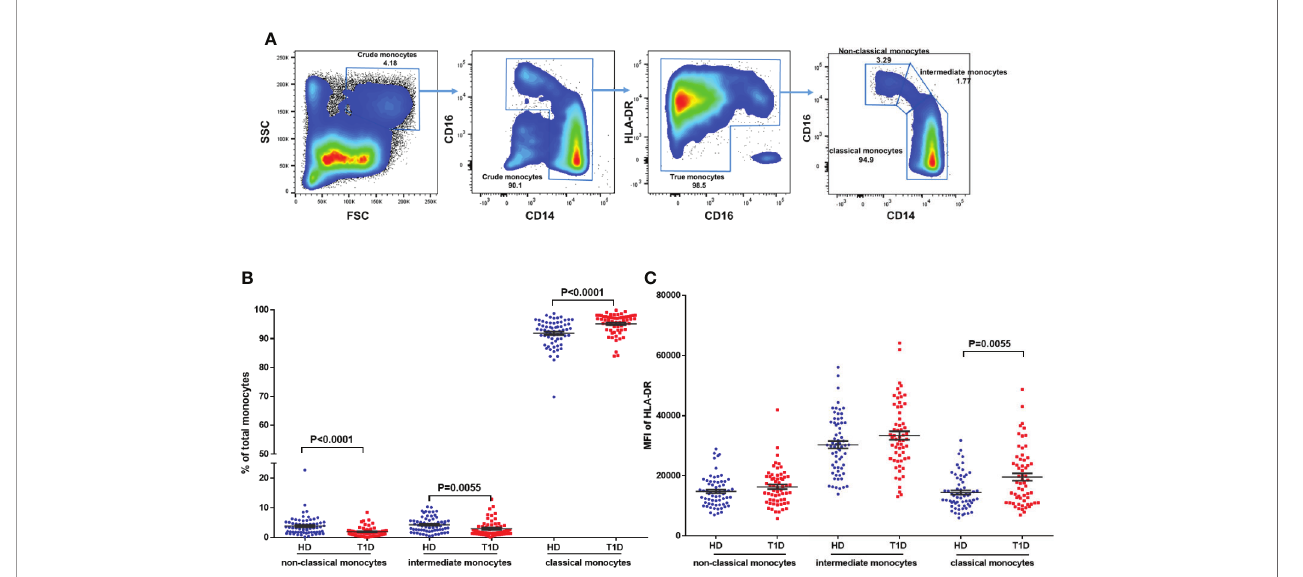
FIGURE 6 | Differences in HLA-DR expression and distribution in circulating monocyte subsets and in T1D compared to age-matched healthy donors (HD). (A) Gating strategy for the determination of peripheral monocyte subsets by fl ow cytometry with the combination of CD14, CD16 and HLA-DR. Three monocyte subsets were de fi ned: non-classical monocytes (CD14 + CD16 ++ ), intermediate monocytes (CD14 ++ CD16 ++ ), and classical monocytes (CD14 ++ CD16 + ). (B) Distribution of monocyte subsets in T1D cases compared to age-matched healthy donors (HD). (C) HLA-DR expression in different monocyte subsets of T1D cases compared to age- matched healthy donors (HD). The results were from 68 autoantibody-positive T1D individuals and 68 age-matched autoantibody-negative healthy controls. Samples from T1D individuals and healthy controls were randomly divided to each independent experiment. One biological sample (from the same healthy donor and drawn at the same time) was performed as control for the experimental reproducibility. Comparisons between T1D and healthy controls were performed by unpaired t test with Welch ’ s correction. A p value <0.05 was considered as signi fi